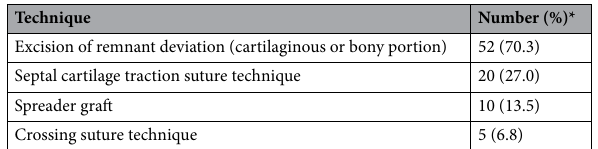
Table 3. Main operative techniques to correct the remnant septal deviation. * The numbers are not mutually exclusive.